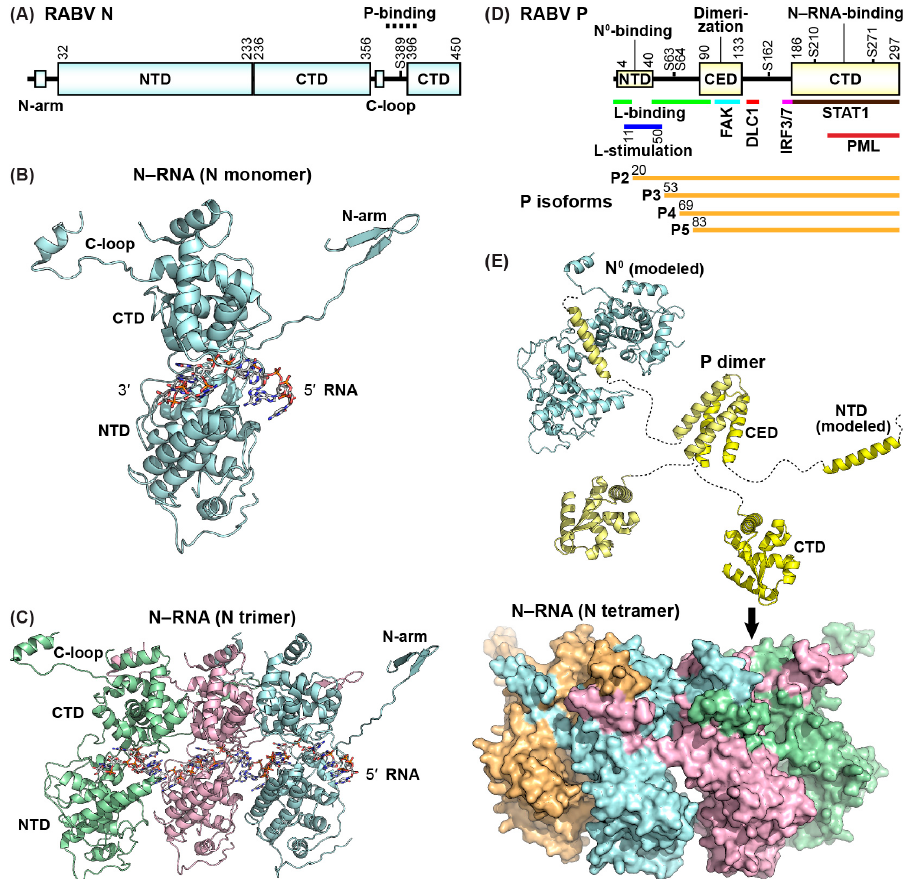
Figure 3. Structures of the rabies virus (RABV) nucleocapsid (N) and phospho- (P) proteins. ( A ) The domain organization of the RABV N protein is schematically shown. NTD and CTD denote N- and C-terminal domains, respectively. Numbers indicates the positions of amino acid residues beginning and ending the domains. A predicted P-binding region on the N–RNA complex is shown by a dashed line. S389 is a phosphorylation site. ( B ) A cartoon representation of the monomeric N protein (PDB id: 2GTT) is shown with encapsidated nine-mer of RNA. Regional landmarks are labeled. ( C ) An assembled trimer of N proteins is shown bound to a 27-mer of RNA. Each monomer of N is shaded in a different color. ( D ) The domain organization of the RABV P protein is depicted with binding sites for RABV (N 0 , RNA-free N protein; L, large protein; N–RNA) and host (FAK, focal adhesion kinase; DLC1, dynein light chain 1; STAT1, signal transducer and activator of transcription 1; PML, promyelocytic leukemia) factors. NTD, CED, and CTD indicate N-terminal, central, and C-terminal domains, respectively. Regions required for stimulation of the L RNA-dependent RNA polymerase activity and inhibition of IRF3/7 (interferon regulatory factor 3/7) activation are shown. Five serine residues (S63, S64, S162, S210, and S271) are noted as phosphorylation sites. P2–5 indicate N-terminal truncation isoforms of the P protein. ( E ) The dimeric RABV P is shown in cartoon form (individual monomers colored yellow and pale yellow) with regional landmarks labeled as in (D). P binds the unassembled N 0 (top) via the N-terminal region of P. The dimerization domain (PDB id: 3L32) is shown central to the figure. A tetramer of N proteins (shaded in different colors) is shown in surface representation, 180 degrees rotated with a slight tilt forward from the view in ( B ) and ( C ). The C-terminal domain of P (PDB id: 1VYI) binds a bipartite binding site involving the C-loops and the surface on CTD of N (below the arrow) on the assembled nucleocapsid. Linker segments are illustrated as dashed lines. The RABV N 0 –P complex is modeled based on the equivalent vesicular stomatitis virus complex in [78]. The RABV P protein (297 amino acids, Figure 3D) is an elongated dimeric protein with structured and unstructured regions and is phosphorylated with cellular kinases [79–81]. The P protein